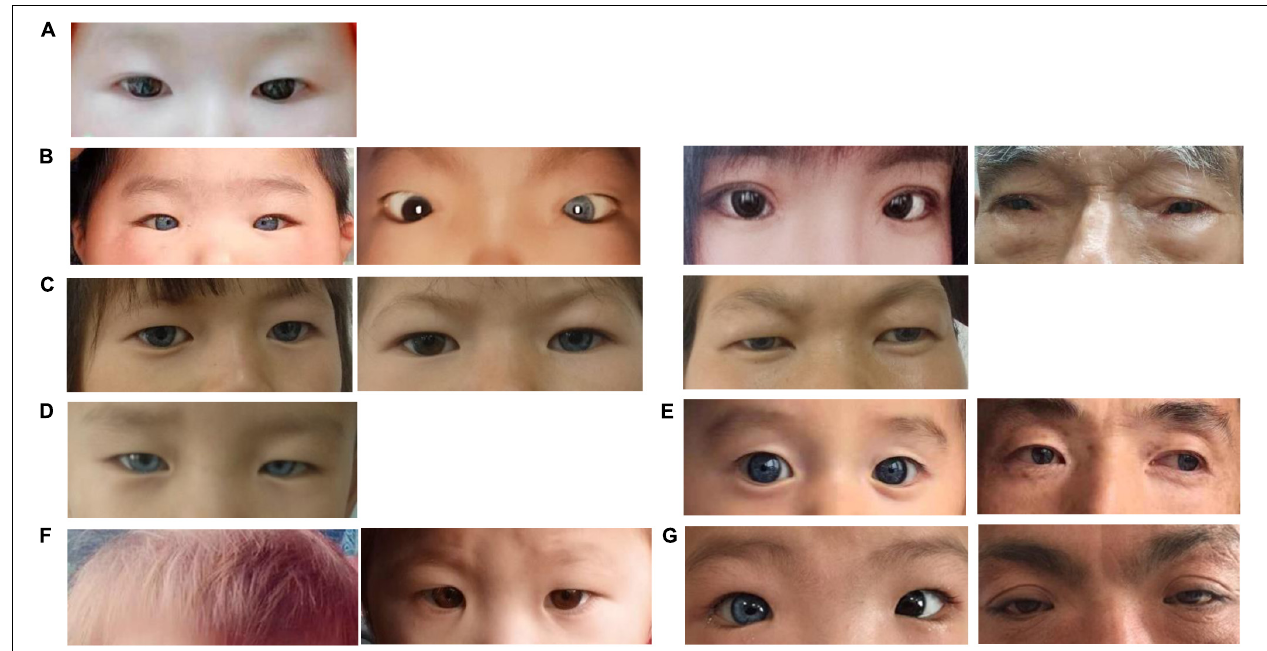
FIGURE 2 | Photographs of affected individuals. (A) WS01-II:1 presented normal pigmentation of the iris, hair, and skin, and without dystopia canthorum. (B) B1, WS02-III:2; B2, WS02-III:1; B3, WS02-II:2; and B4, WS02-I:1. They all presented dystopia canthorum, while WS02-III:2 has bilateral blue iris and WS02-III:1 has unilateral. (C) C1, WS03-II:1; C2, WS03-II:2; and C3, WS03-I:2. They presented bilateral or unilateral blue iris. (D) WS04-II:1 presented complete bilateral blue iris. (E) E1, WS05-IV:1 presented complete bilateral blue iris. E2, WS05-III:1 presented complete bilateral blue iris and special brown freckles on the face. (F) F1, F2, WS06-II:1 presented yellow hair and normal iridis color. (G) G1, WS07-II:1 presented unilateral blue iris and dystopia canthorum. G2, WS07-II:1 presented dystopia